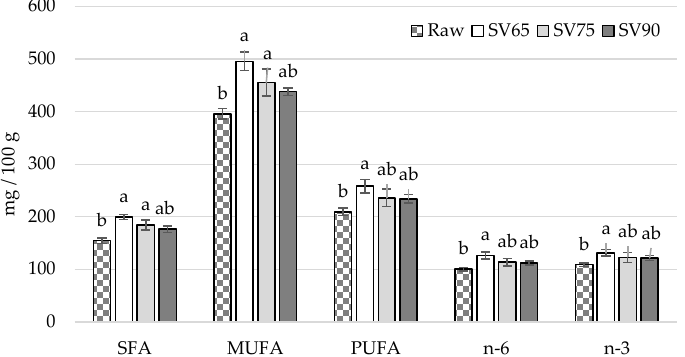
Figure 2. Comparison of fatty acids contents (mg/100 g) in pikeperch fillets: raw and after sous vide treatment proceeded at 65 °C for 45 min (SV65), 75 °C for 20 min (SV75), and 90 °C for 10 min (SV90); vertical bars refer to standard error of the mean; a,b — values denoted with different letters differ significantly at p < 0.05; SFA — saturated fatty acids; MUFA — monounsaturated fatty acids; PUFA — polyunsaturated fatty acids.